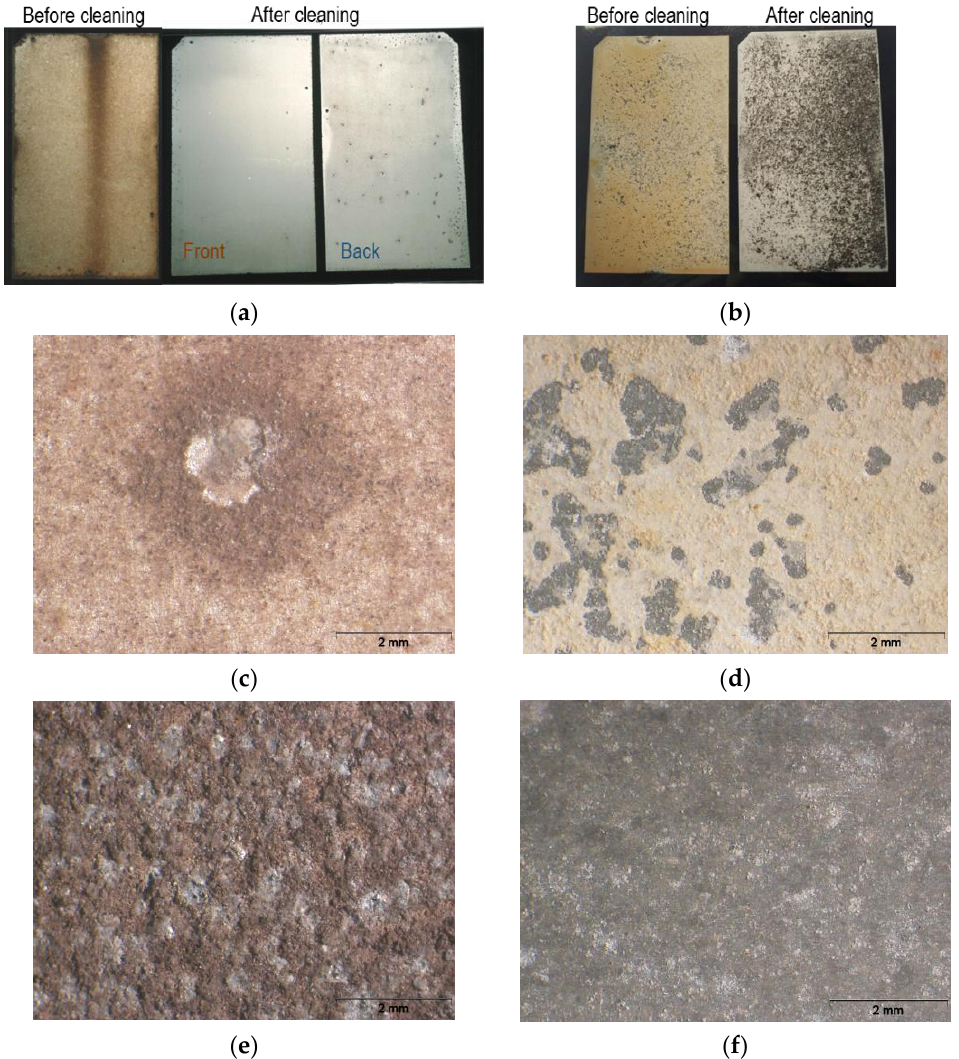
Figure 4. Test specimens exposed at Barreiro (on the left) and at Rodão (on the right): ( a , b ) visual aspects before and after cleaning ( Steps I and II ); ( c , d ) OM images of the anodized aluminum front surfaces after 10 years’ exposure and ( e , f ) OM images of the bare aluminum specimens’ front surfaces after the same time of exposure.